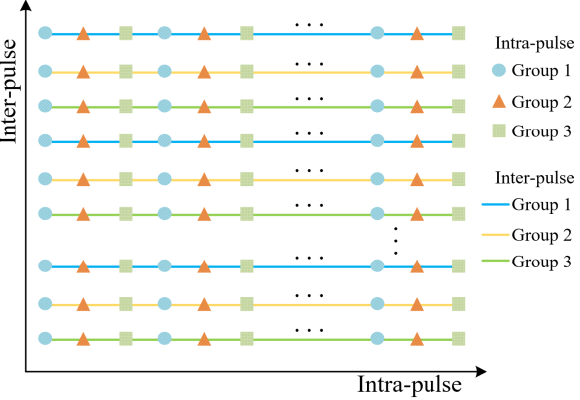
Figure 4. Schematic diagram of